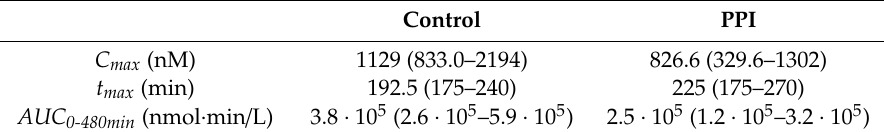
Table 4. Pharmacokinetic parameters of the ritonavir plasma concentration-time profiles following oral intake of a Norvir tablet in the control and PPI conditions. Median (range) with n = 4.